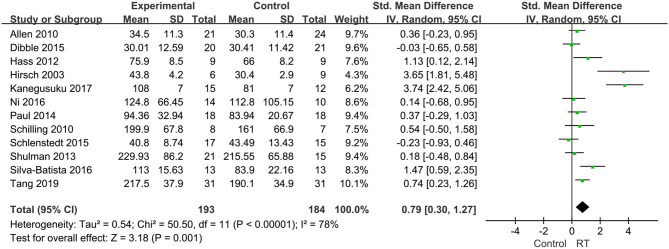
Forest plots of the effects of lower limb RT on leg strength in PD. CI, confidence interval.